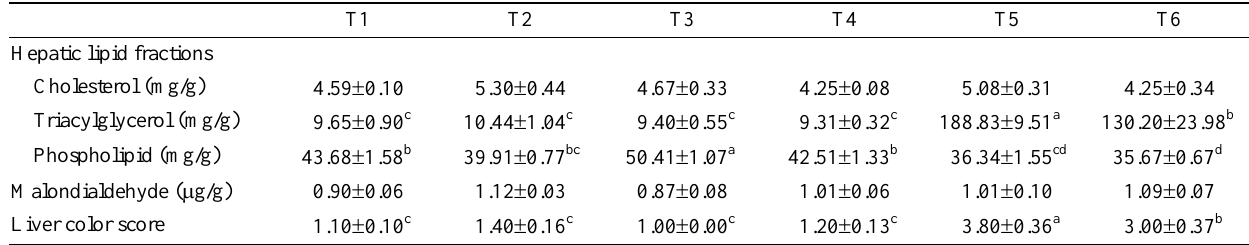
Table 5. Effects of various treatments for inducing fatty liver hemorrhagic syndrome on the concentrations of hepatic lipid fractions and malondialdehyde in immature laying-type male chicks